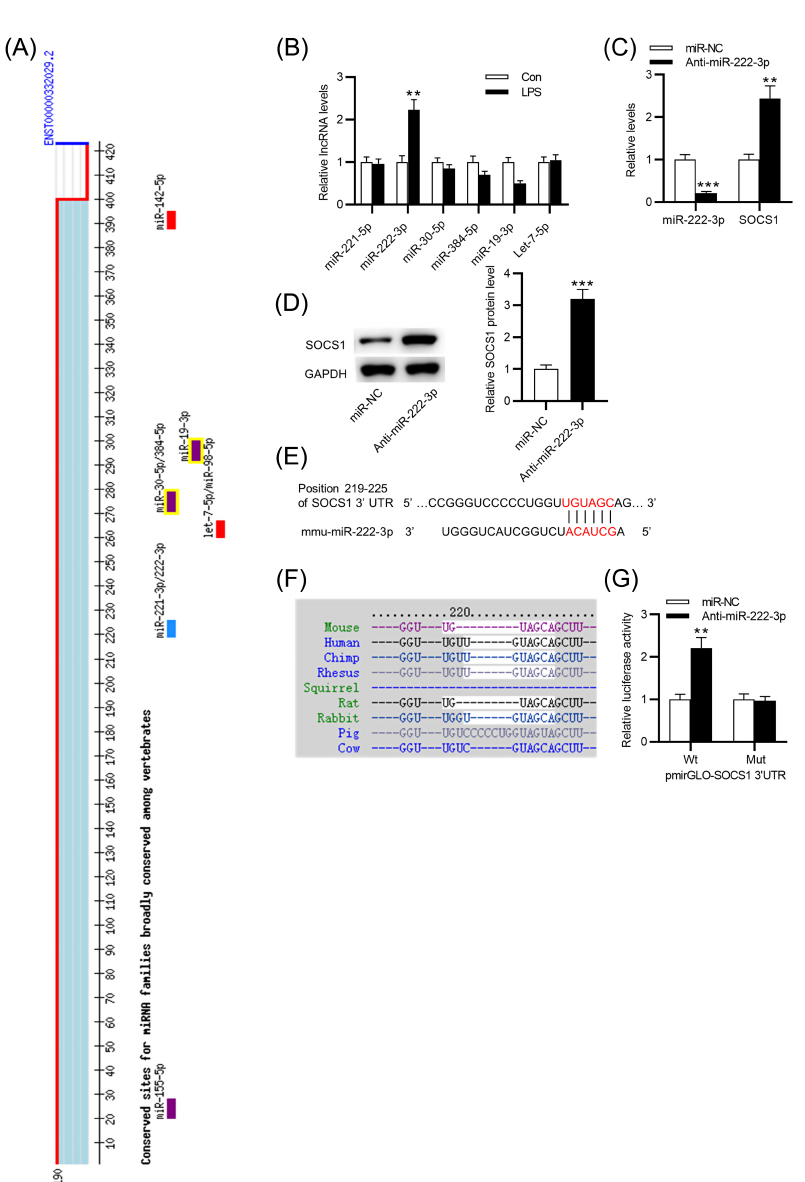
Figure 3. SOCS1 is targeted by miR-222-3p. (A) TargetScan prediction results show 9 miRNAs that have conserved sites for SOCS1 . (B) The miRNA expression in LPS-treated RAW264.7 cells was measured by RT-qPCR. (C) MiR-222-3p expression and SOCS1 expression in RAW264.7 cells transfected with anti-miR-222-3p or control. (D) SOCS1 protein expression in RAW264.7 cells transfected with anti-miR- 222-3p or control. (E-F) Position 219-225 of SOCS1 3’UTR in miR-222-3p is shown highly conserved in multiple species. (G) The luciferase activity of SOCS1 3’UTR in 293T cells transfected with anti-miR-222-3p or control was measured by luciferase reporter assay. ** P < .01, *** P < .001. LPS, lipopolysaccharide, RT-qPCR, reverse transcription-quantitative polymerase chain